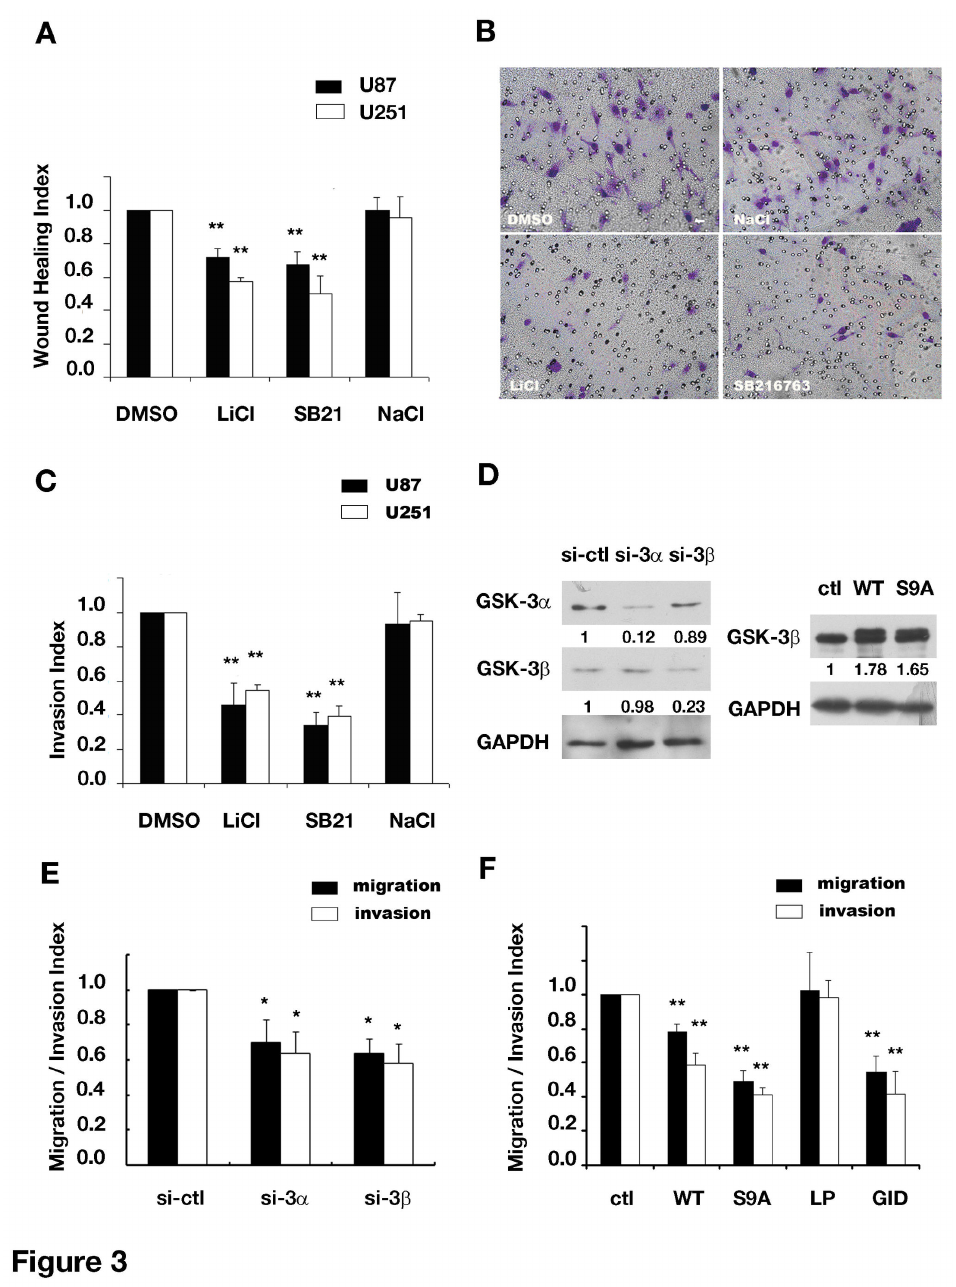
Figure 3. Inhibiting GSK-3 blocked migration and invasion of human glioma cells. (A) Wound recovery of U251 and U87 cells in the presence of indicated agents. ** P <0.01 versus DMSO. (B and C) Blockade of cell migration and invasion in the presence of GSK-3 inhibitors. (B) Representative images of U251 cells in the transwell invasion assay in different treatments. Original magnification, 100× . (C) Quantifications of transwell migration in invasion assays of U251 and U87 cells. ** P <0.01 versus DMSO. (D) Western blot analysis of U87 cell lysates transfected with indicated constructs. The values indicated the amount of indicated proteins normalized to that of GAPDH and compared with non-sense ( si-ctl ) or pcDNA3 ( ctl ) control group. (E) GSK-3 down-regulation by small interfering RNA inhibited U87 cell migration and invasion in the transwell assay. * P <0.05 versus non- sense control group ( si-ctl ). (F) Uniform up- or down-regulation of GSK-3β activities inhibited U87 cell migration and invasion in the transwell assay. ** P <0.01 versus pcDNA3 ( ctl ). si-3α, siRNA against GSK-3α; si-3β, siRNA against GSK-3β; WT, wild-type form of GSK-3β; S9A, constitutively active form of GSK-3β; GID, inhibitory peptide of GSK-3β; LP, mutant of GID without inhibitory effect. LiCl, 20mM, SB216763, 20μM, NaCl, 20mM. Data were mean ± SD of three independent experiments in triplicate. doi: 10.1371/journal.pone.0081814.g003 PLOS ONE |